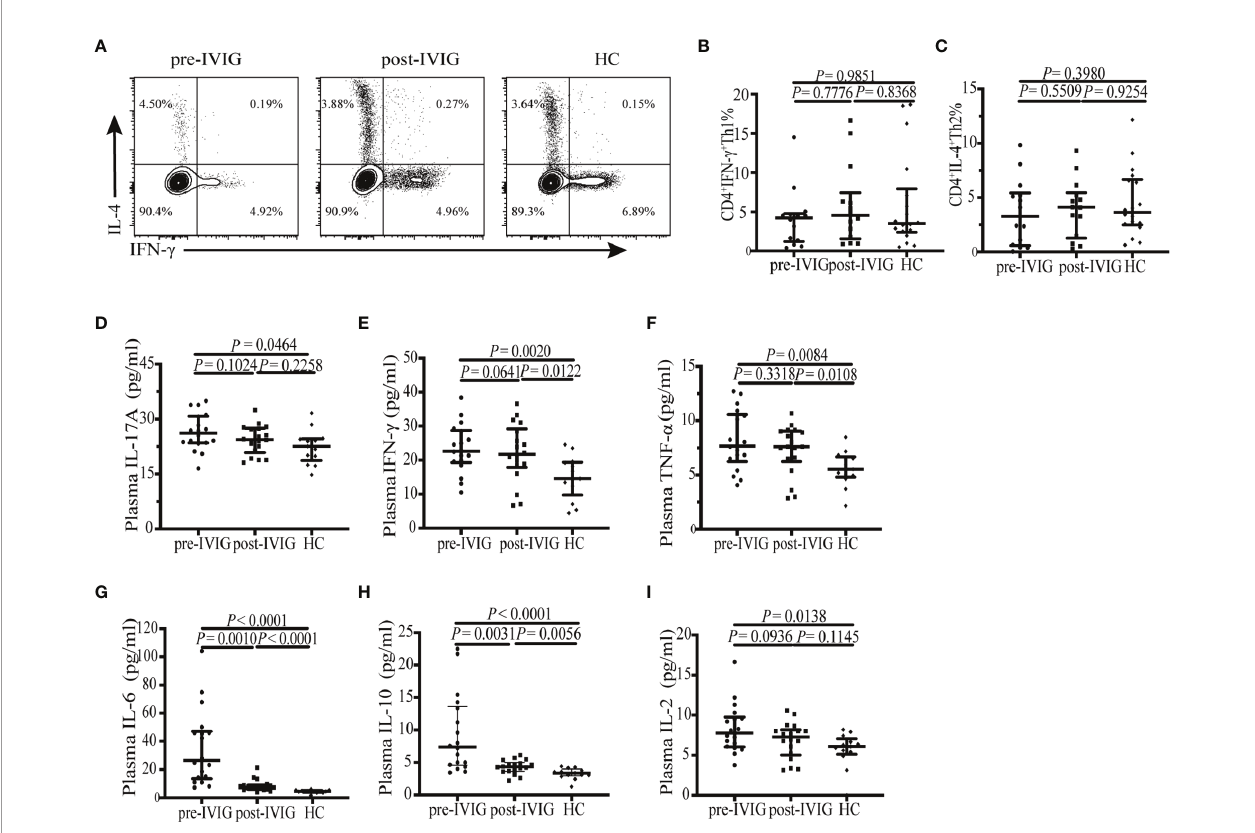
FIGURE 4 | Flow cytometry analysis of the intracellular cytokine and plasma cytokine levels. (A) The gating strategy for determining CD4 + IFN- g + Th1 and CD4 + IL- 4 + Th2 cells is shown. (B) Percentage of circulating CD4 + IFN- g + Th1 cells in patients with KD (n = 14) and HCs (n = 18). (C) Percentage of circulating CD4 + IL-4 + Th2 cells in patients with KD (n = 14) and HCs (n = 18). (D – I) Plasma levels of the cytokines IL-17A, IFN- g , TNF- a , IL-6, IL-10, IL-2 were detected in patients with KD (n = 19) and HCs (n = 13) using cytometric bead array. Horizontal bars represent median values, and error bars represent the interquartile